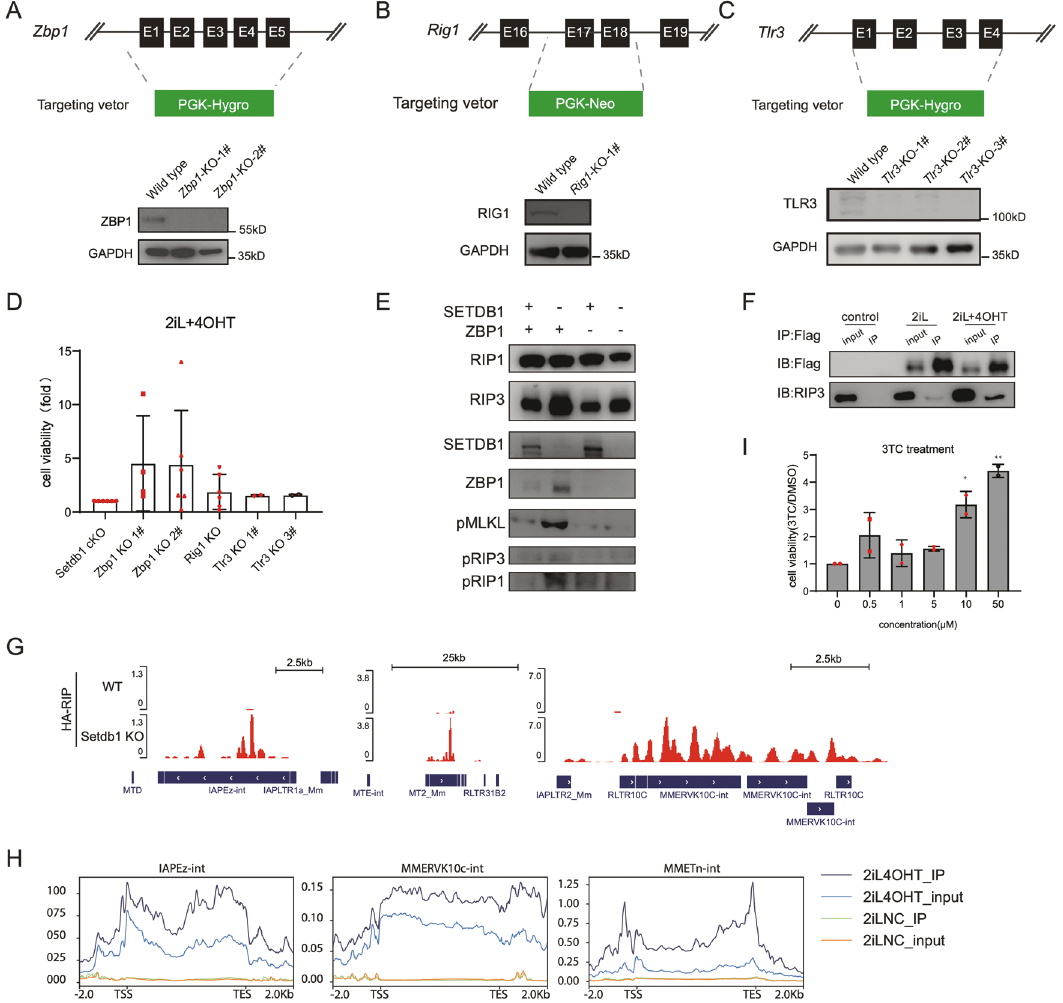
Fig. 6 ZBP1 senses ERV RNA/DNA to trigger necroptosis. A – C Schematic view of Zbp1/Rig1/Tlr3 KO strategy and western blot analysis demonstrates the expression of ZBP1/RIG1/TLR3 in wild type and corresponding knockout mESCs. D Cell viability assay of Zbp1 KO, Rig1 KO and Tlr3 KO cells using CCK8 test. ( n = 4, biological replicates; error bar, SD; * p < 0.05, ** p < 0.01) E Western blot analysis of the necroptotic markers such as RIP3 and pRIP in Setdb1 cKO cell and Zbp1 KO cells with/without 4OHT treatment. F Co-IP of overexpressed 3×Flag-HA-ZBP1 and RIPK3. G IGV of HA-RIP on IAPEz-int, MT2 and MMERVK10c. H Representative ERVs enriched by 3×Flag-HA-ZBP1. I Cell viability assay of Setdb1 cKO mESCs treated with different concentration of 3TC ( n = 2, biological replicates; error bar, SD; * p < 0.05, ** p <